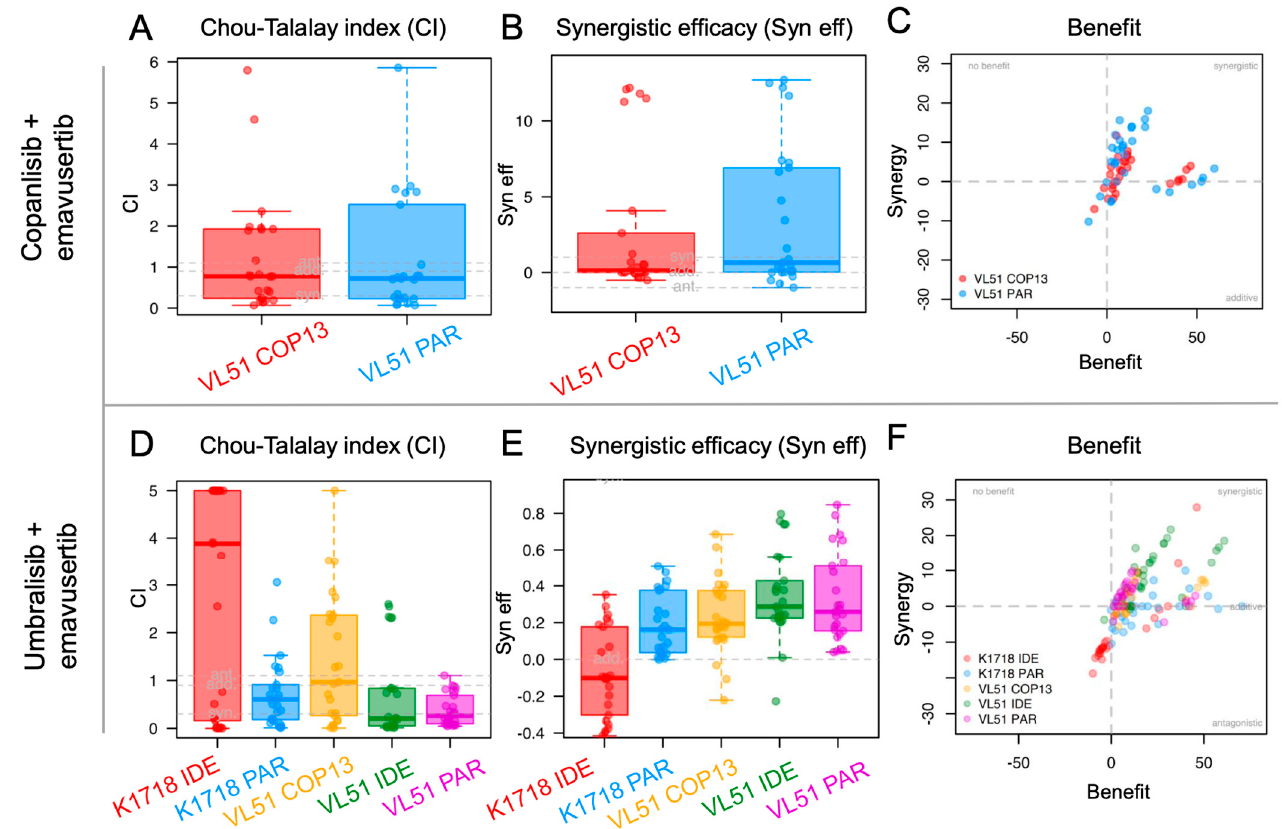
Figure 4. IRAK4 inhibitor emavusertib in combination with copanlisib and umbralisib in MZL cell lines. Upper panel: combination of emavusertib and copanlisib in VL51 parental (PAR) and copanlisib-resistant (COP13) line. Lower panel: combination of emavusertib and umbralisib in VL51 and K1718 parental (PAR) and resistant models to copanlisib (COP13), idelalisib (IDE) or ibrutinib (IBR). In both panels, cells were exposed (72 h) to increasing doses of PI3K inhibitors alone and in combination with emavusertib followed by MTT. ( A , D ): syn, synergism (CI < 0.9); add, additive effect [0.9 < CI < 1.1]; ant, antagonism/no benefit (CI > 1.1). ( B , E ): syn, synergism (syn eff > 1); add, additive effect [ − 1 < syn eff < 1]; ant, antagonism/no benefit (syn eff < − 1). Each dot represents the CI value for a single ratio of copanlisib / emavusertib (upper panel) or umbralisib /emavusertib (lower panel). ( C , F ): Summary plot of benefit in terms of additivity or synergy, as described in the method section, for the combinations of emavusertib with copanlisib (upper panel) or umbralisib (lower panel).